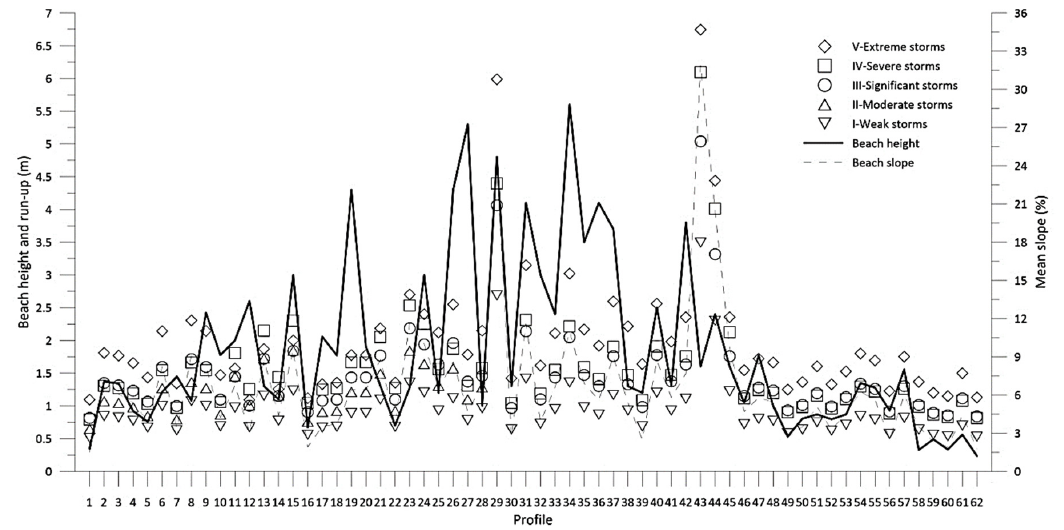
Figure 8. Morphological characteristics of cross-shore profiles and mean wave run-up per storm class.